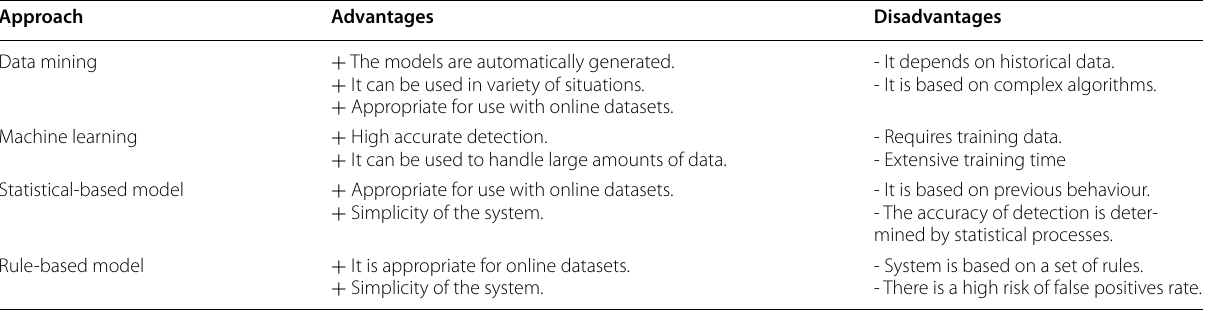
Table 6 Merits and demerits of anomaly-based detection techniques Approach